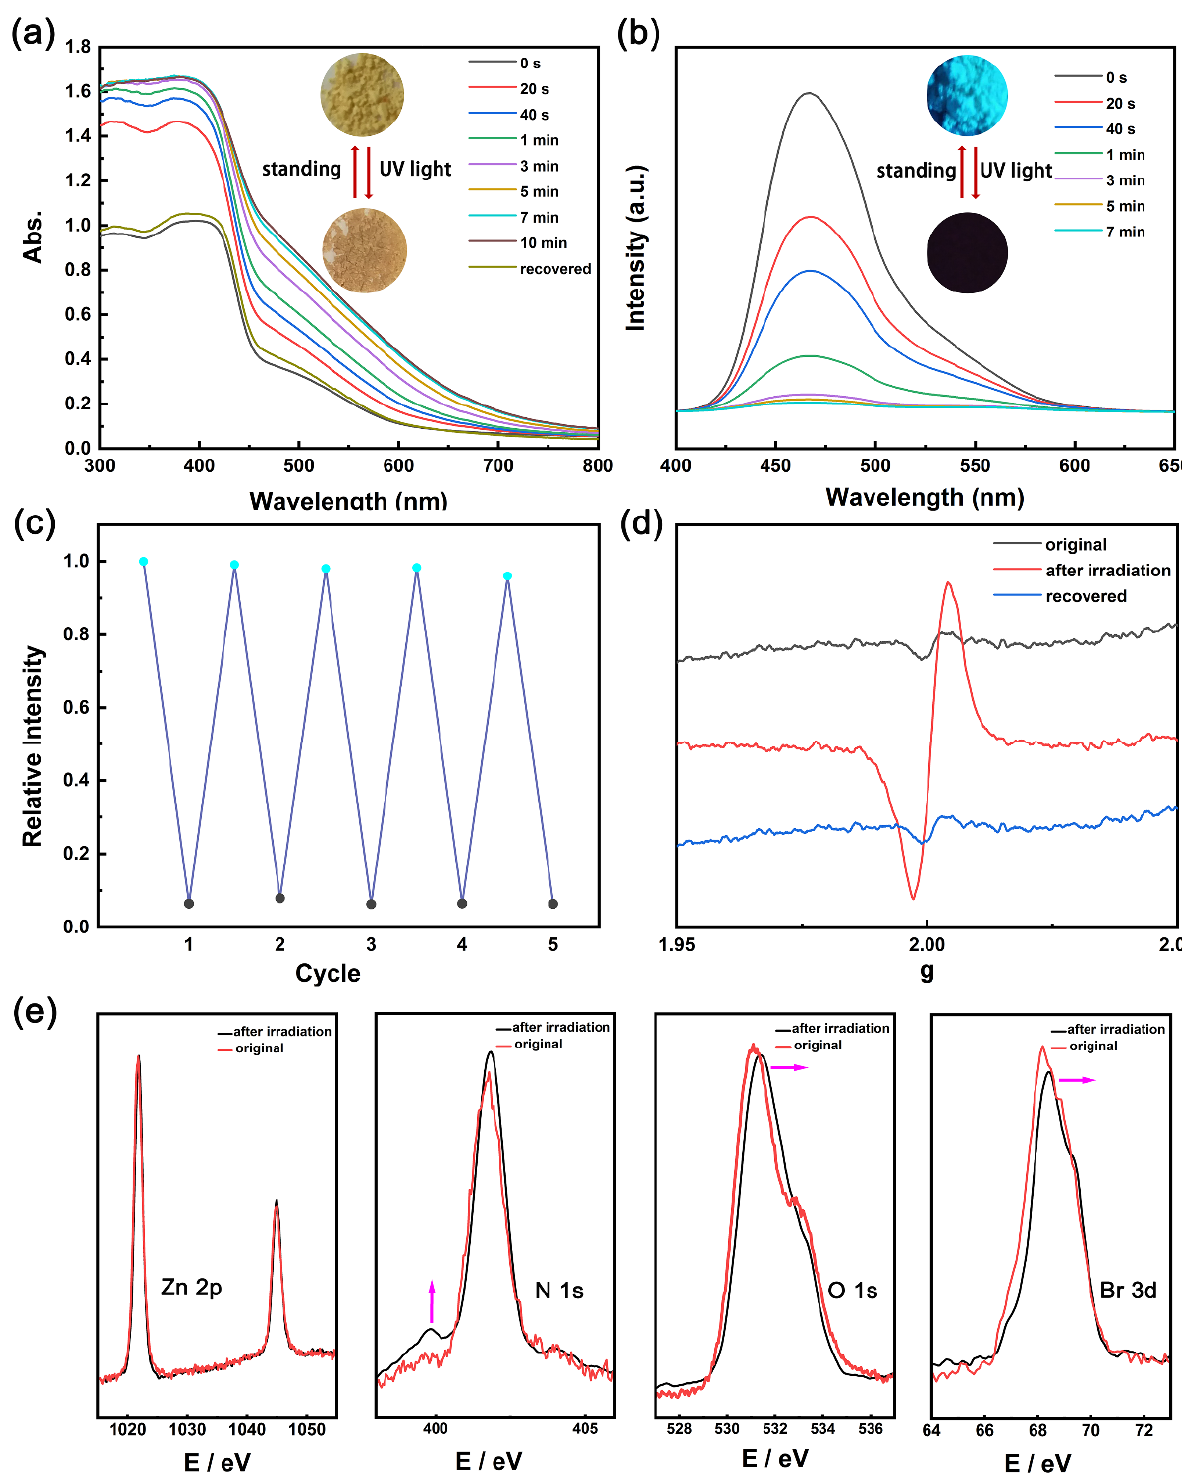
Figure 3. ( a ) Solid − state UV − vis spectra show the photochromic behavior of the Zn − Oxv compound. The inset shows the color change of Zn − Oxv powder. ( b ) The emission spectra of the Zn − Oxv compound changed during UV light illumination. The inset shows disappearance of visible emission. ( c ) Five cycles of fluorescence on − off switching at λ = 467 nm. The emission intensity of recovery state (blue point) and stimulated state (black point). ( d ) ESR spectra for the Zn − Oxv compound before, after irradiation and recovered in the solid state at room temperature. ( e ) High − resolution XPS spectra of Zn 2p, N 1s, O 1s and Br 3d for the Zn − Oxv compound before and after irradiation.